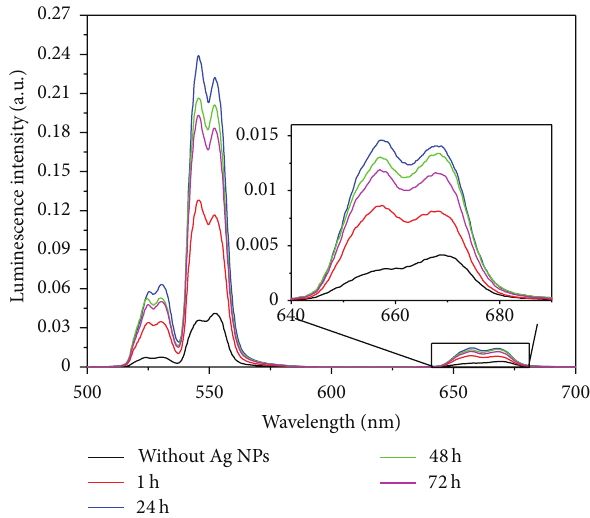
Figure 14: Emission spectra of TBW-Er:Ag glasses for different heat-treatment times